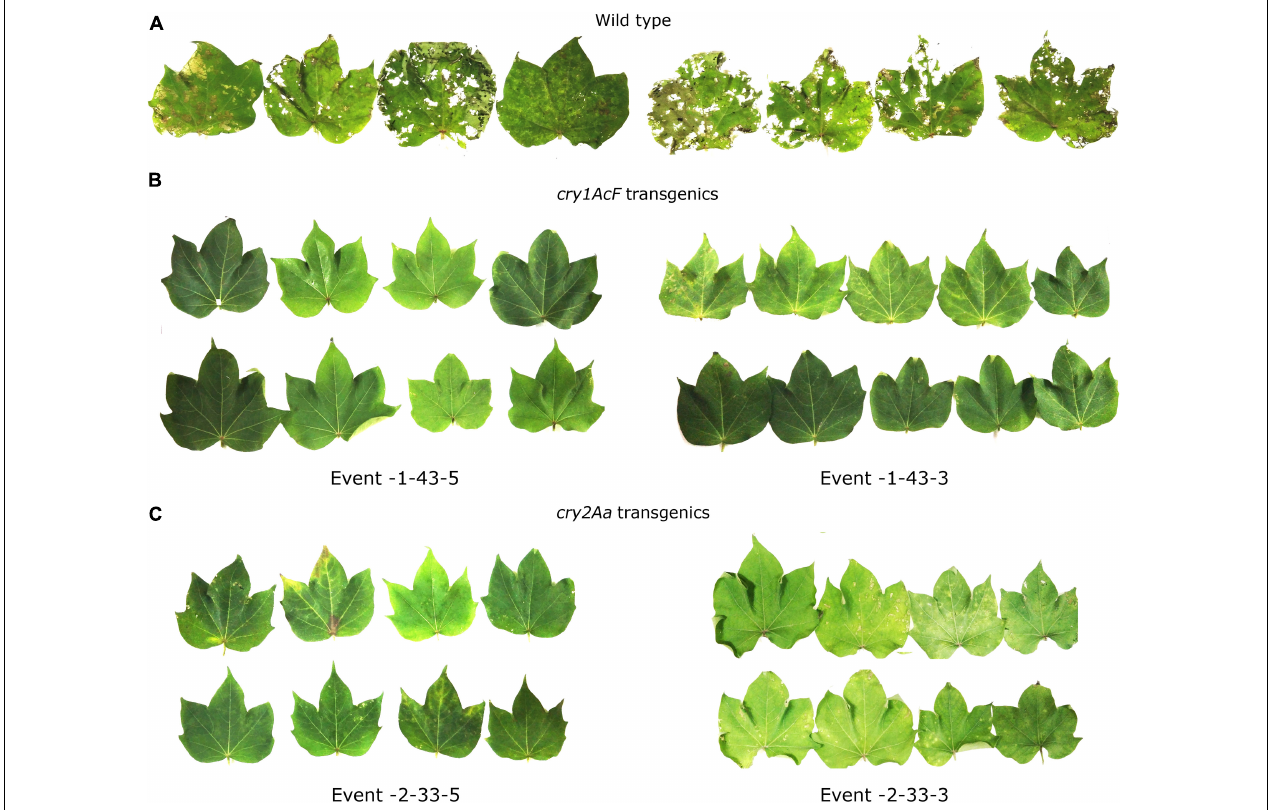
FIGURE 7 | In vitro detached leaf bioassay to demonstrate stability of the selected transgenic events to boll worm challenge in T 3 generation. Leaves of (A) wild type and (B,C) transgenic plants of cry1AcF and cry2Aa events challenged with 10 neonate larvae of Helicoverpa armigera.